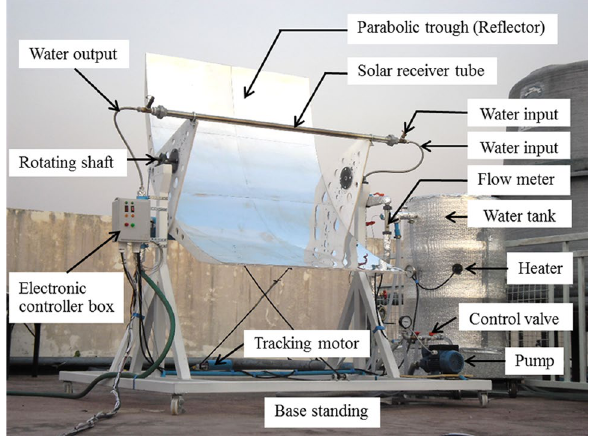
Fig. 3 The overview of the PTC prototype using different thicknesses of Ni-Al coating as the solar absorber of the receiver